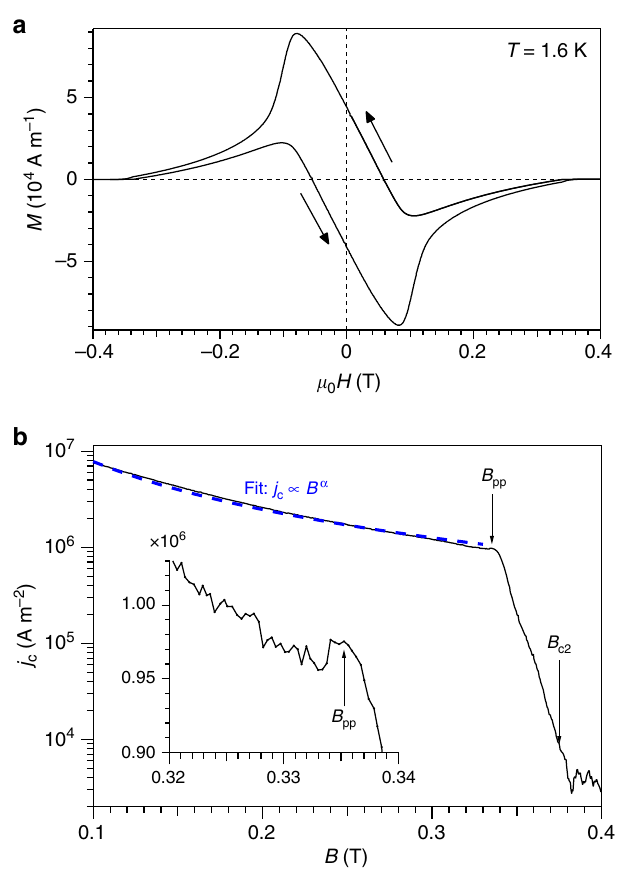
Fig. 3 Magnetometry at 1.6 K. a M ( H ) loop for our vanadium single-crystal with H k ½ 111 (cid:4) . b Critical current density j c calculated from the width Δ M of the magnetisation loop. j c ( B ) decreases monotonically except for a small peak, labelled B pp , observed just before the sharp downturn where thermal fl uctuations start depinning vortices. The dashed line is a fi t to an algebraic decay j c ∝ B α . Fitted value of α = − 1.7. Inset is a magni fi cation of the